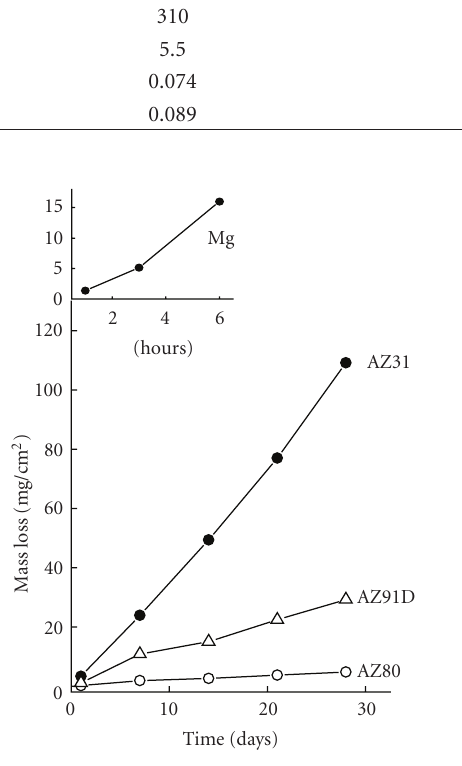
Figure 4: Electrochemically estimated corrosion losses of the materials immersed in 3.5 wt.% NaCl